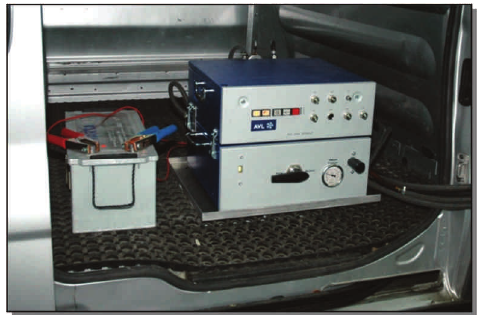
Fig. 4. KMA Mobile Fuel Flow Meter